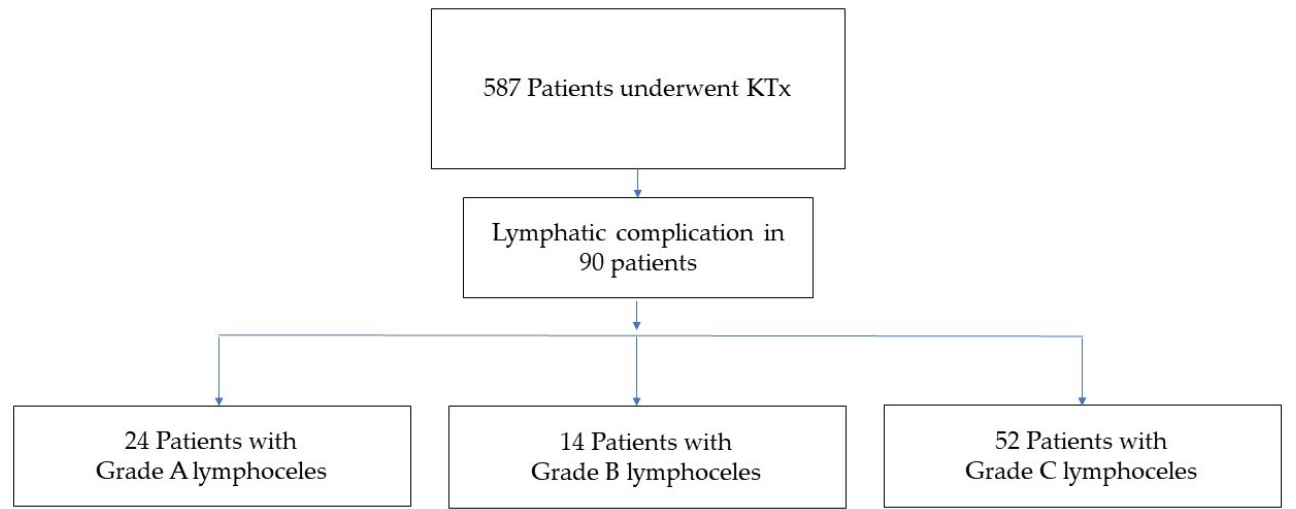
Figure 1. Diagram showing the total number of kidney transplantations and number of patients with postoperative lymphatic complications, divided into Grade A, B, and C.